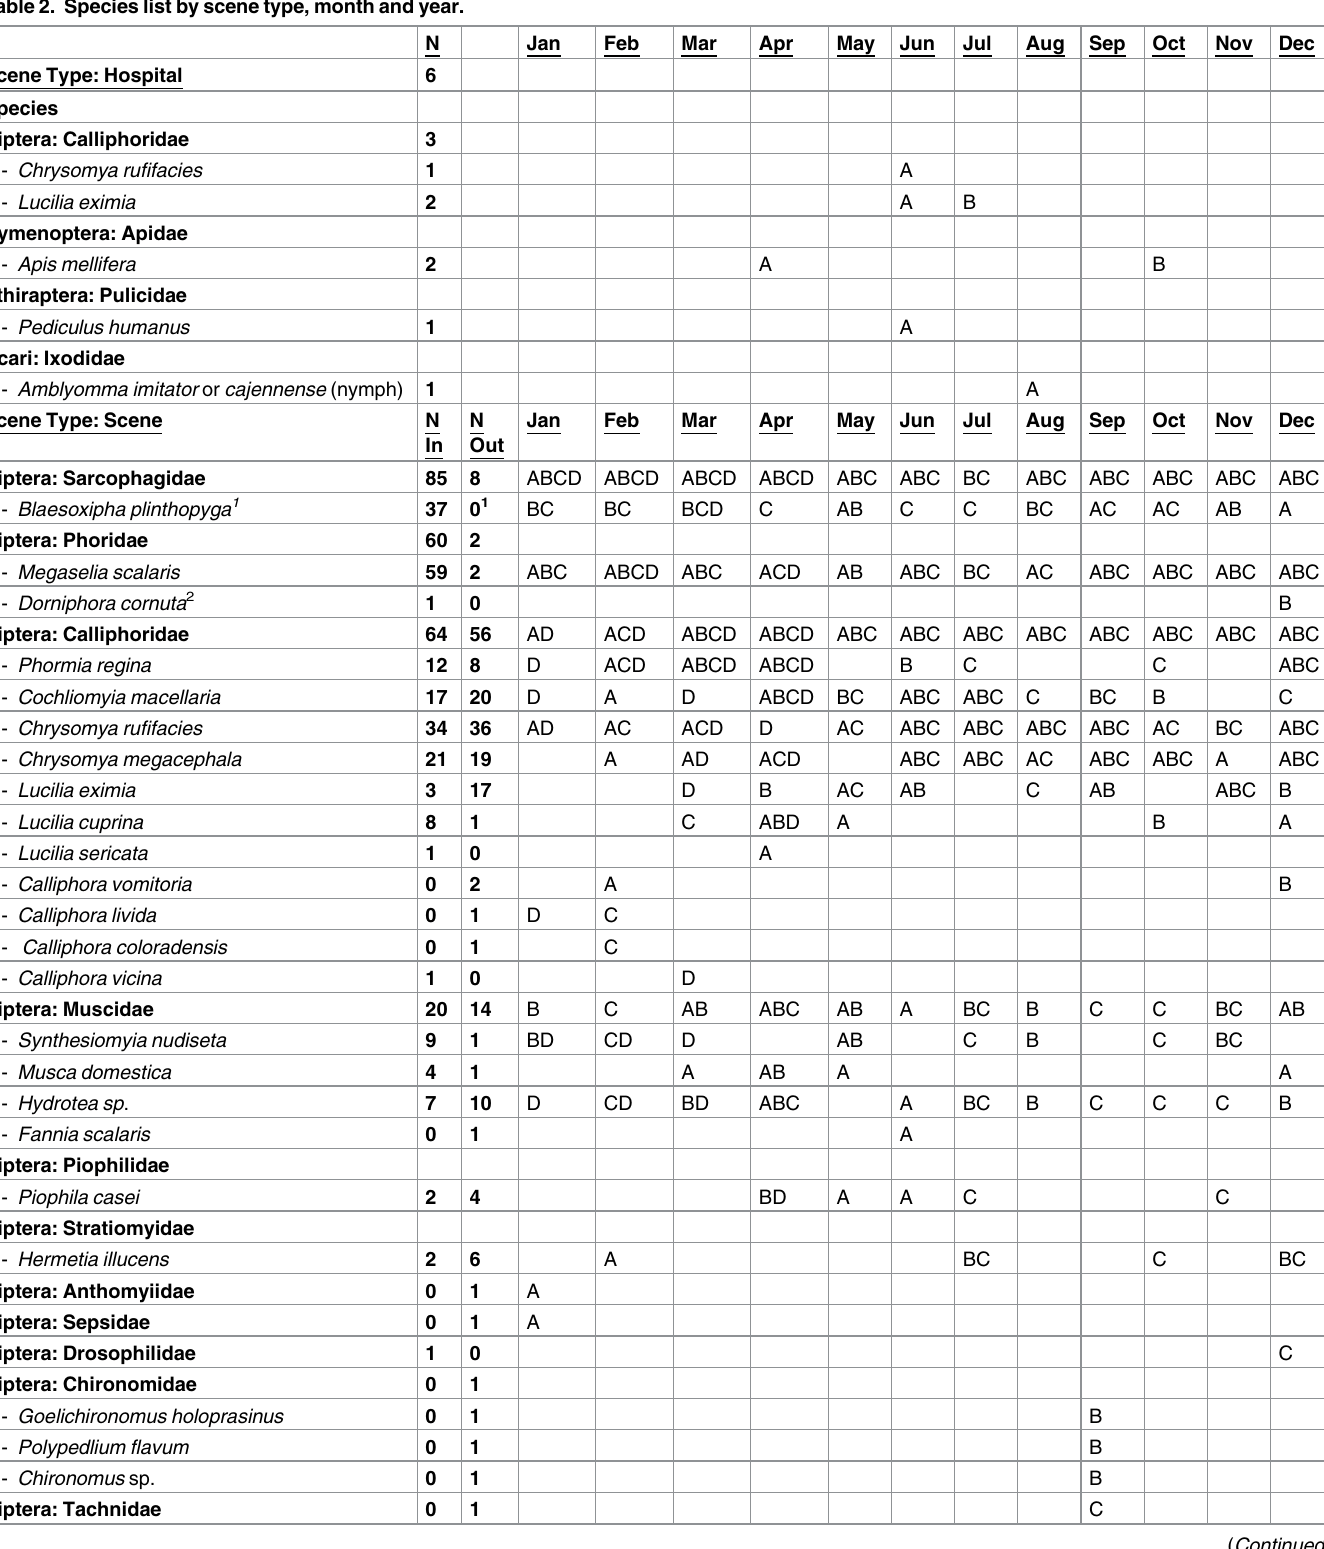
Table 2. Species list by scene type, month and